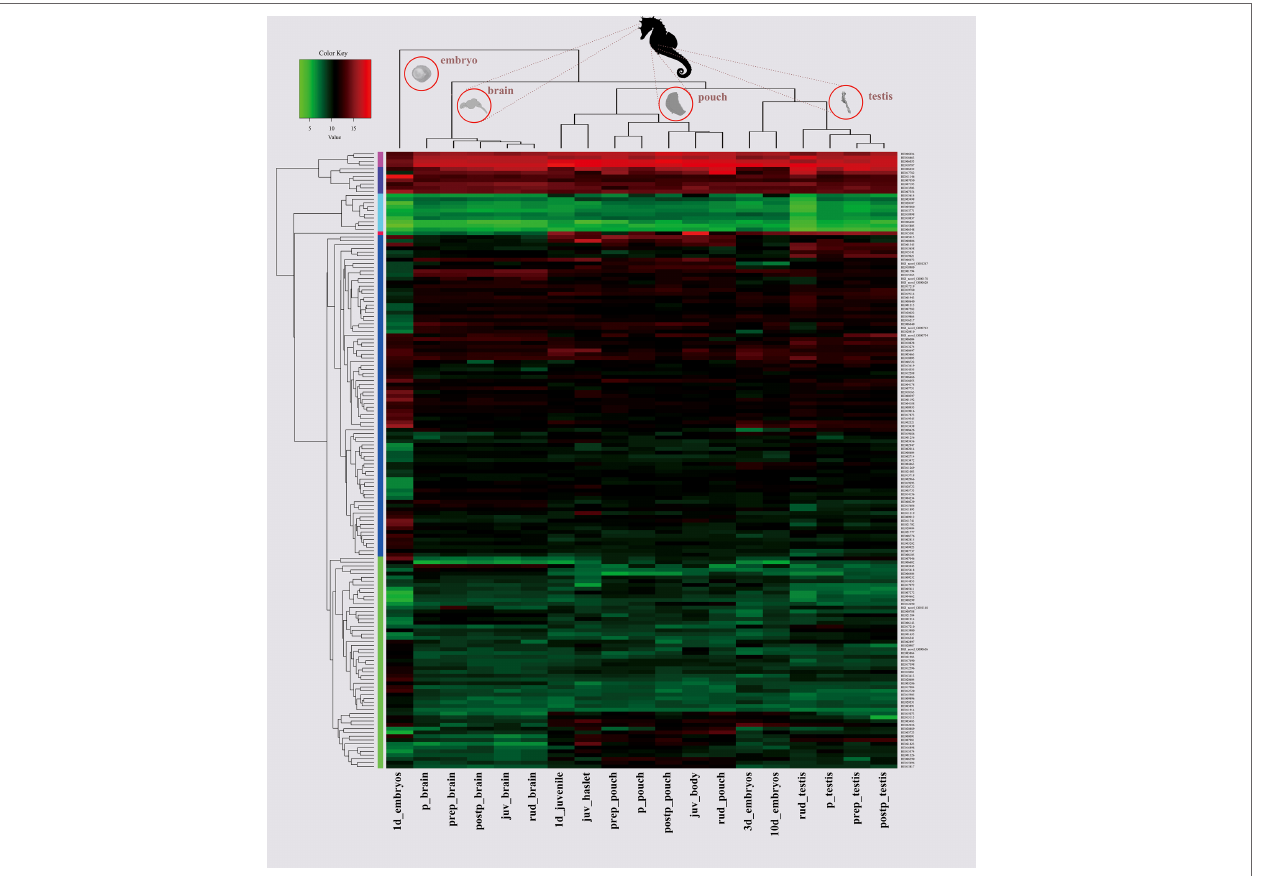
FIGURE 5 | A heatmap of 209 AHTP-rich genes in the seahorse brain, pouch and testis at different developmental stages. X-axis shows clusters of the samples, and Y-axis refers to clusters of the AHTP-derived genes. Color key indicates the intensity associated with normalized transcription values. juv, juvenile; p, pregnancy; prep, pre-pregnancy; postp, post-pregnancy; rud, rudimentary.